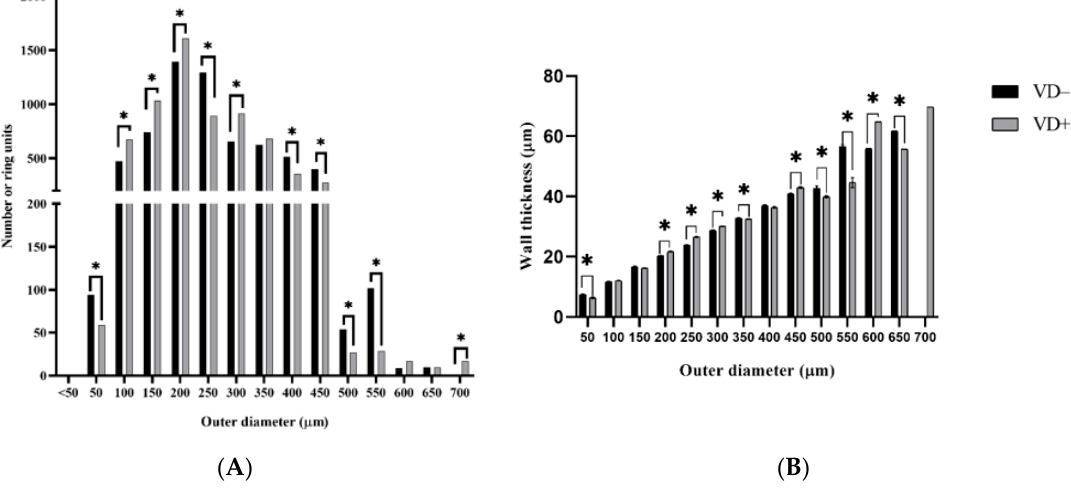
Figure 4. Analysis of ring units. ( A ) Number of 50 μ m ring units as a function of different diameter ranges. In VD − networks, the number of rings decreased in the range of 100–300 μ m (except at 250